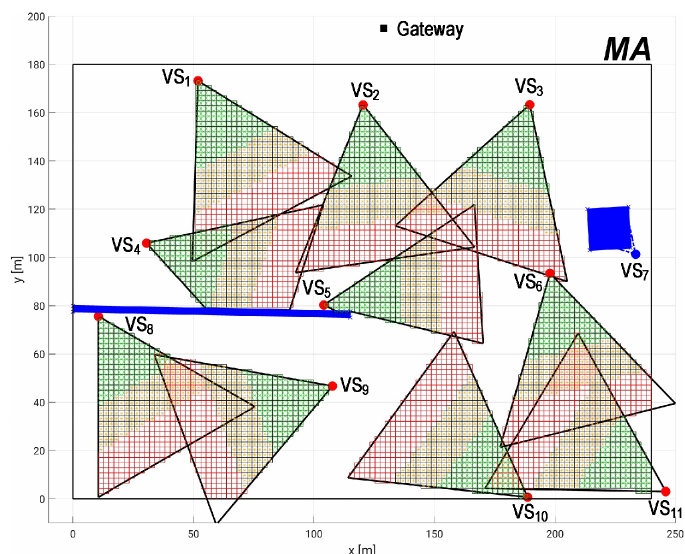
Figure 14. Network deployment with considerable FoV